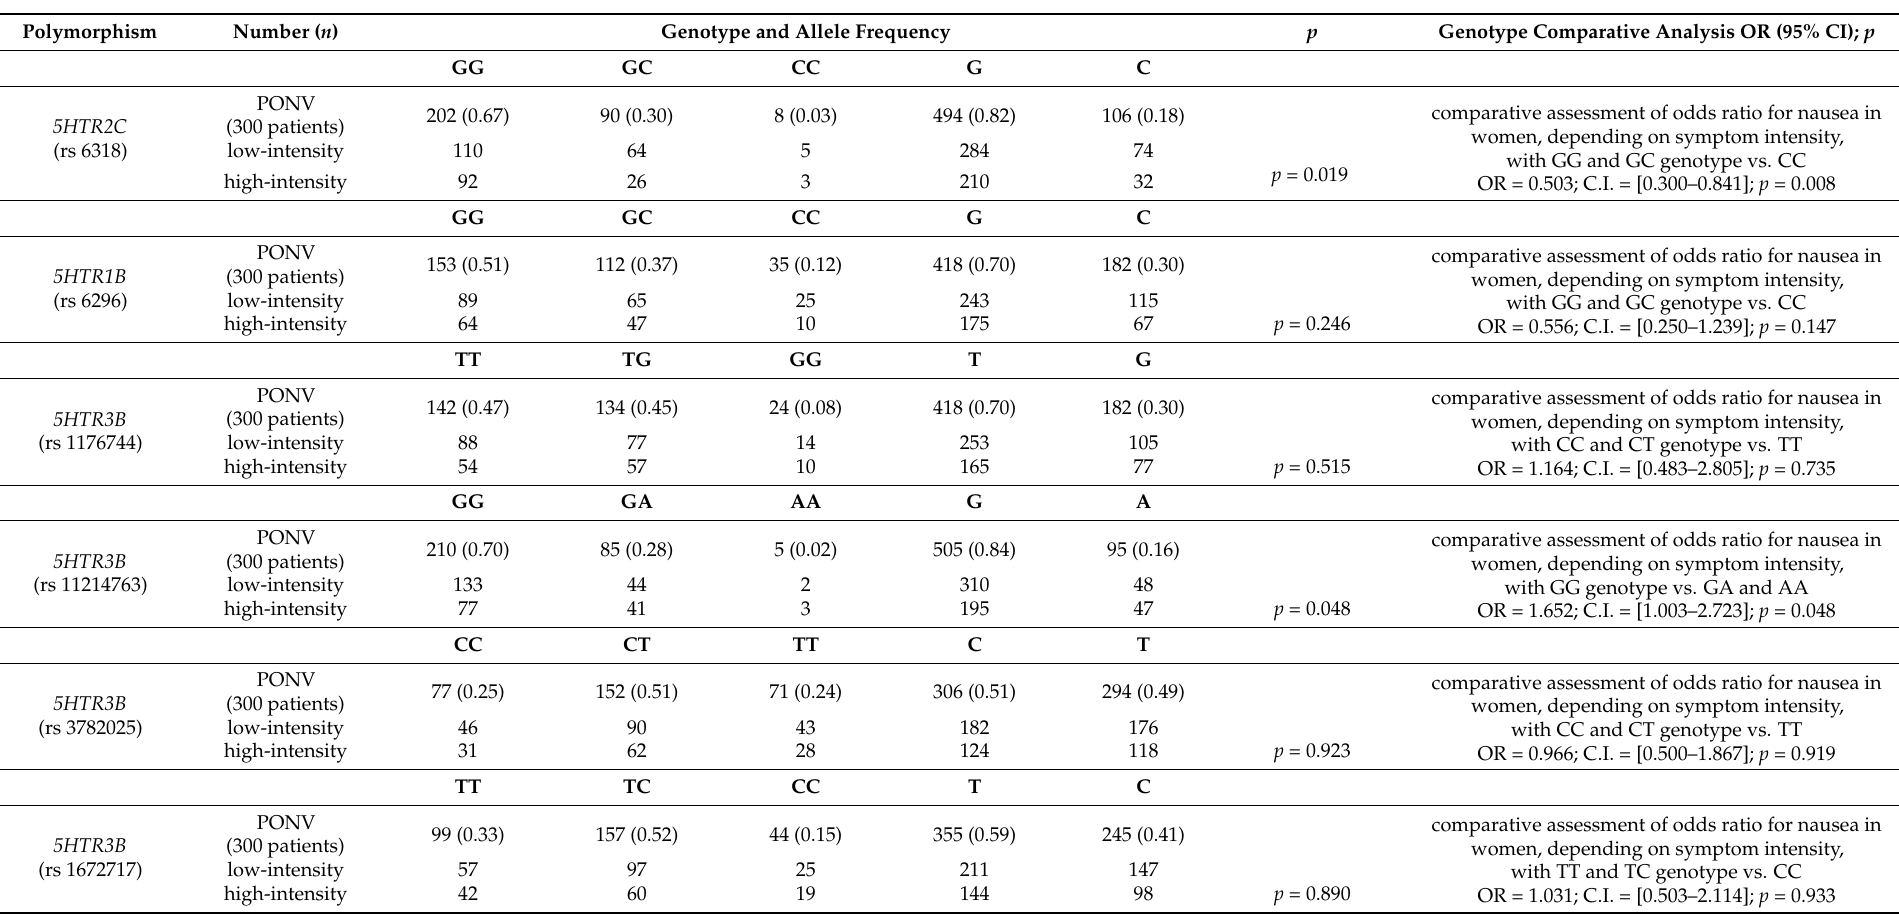
Table 2. Distribution of alleles and genotypes of candidate gene polymorphisms in the etiology of postoperative nausea and vomiting (PONV) in a group of women operated on by hysteroscopy and gynecological laparoscopy due to infertility, depending on the severity of the ailments.